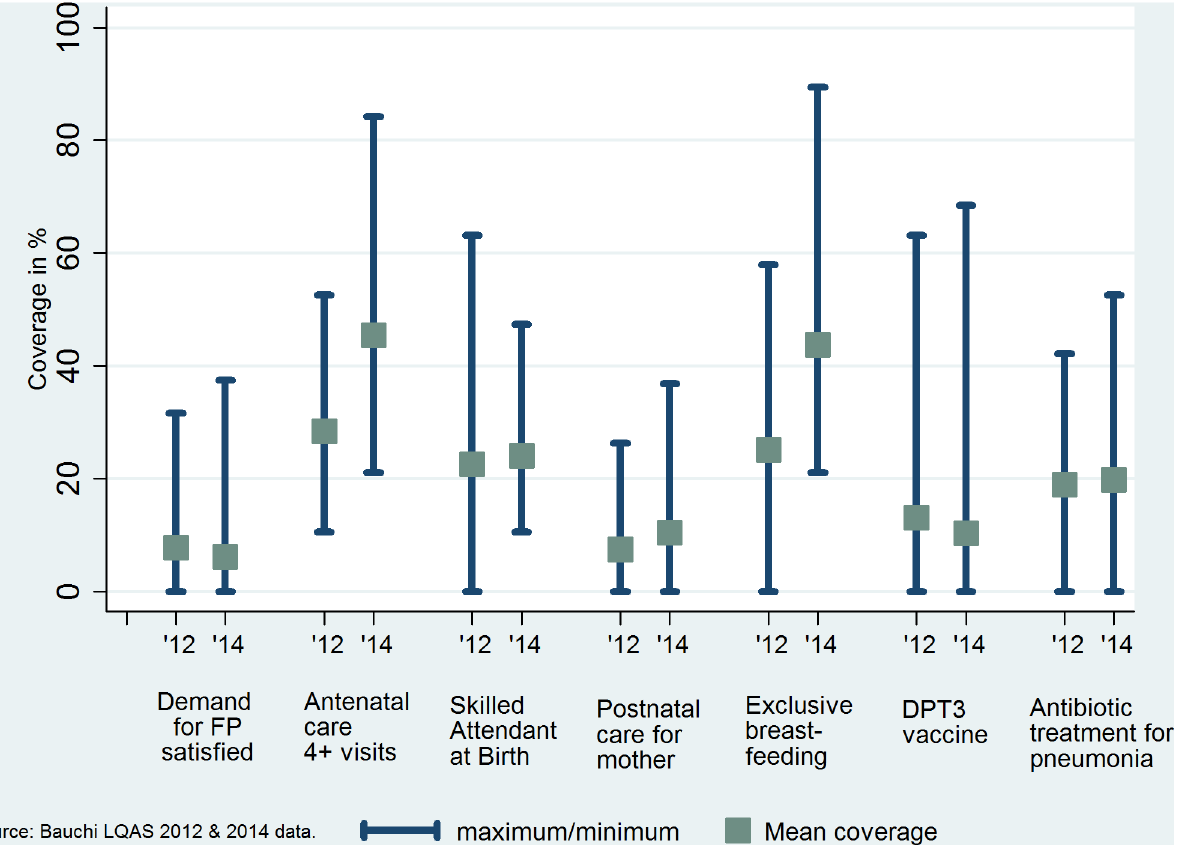
Fig 1. Coverage levels of selected indicators across the continuum of care, 2012 & 2014: Bauchi state coverage range (minimum and maximum) and average.